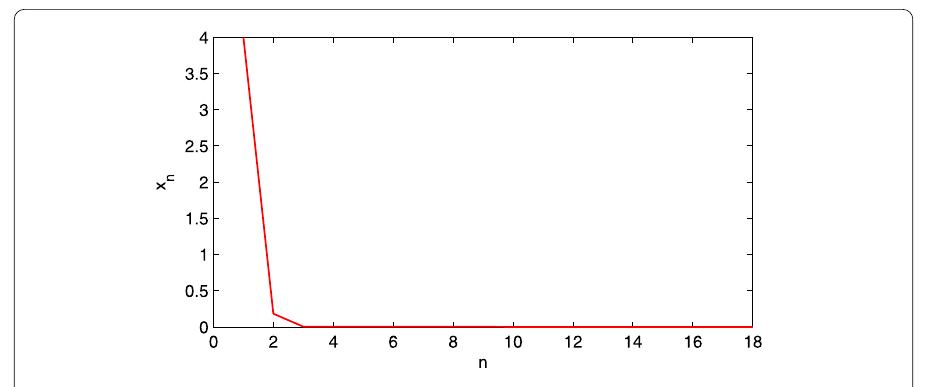
Figure 1 The convergence of { x n } with initial x 1 = 4